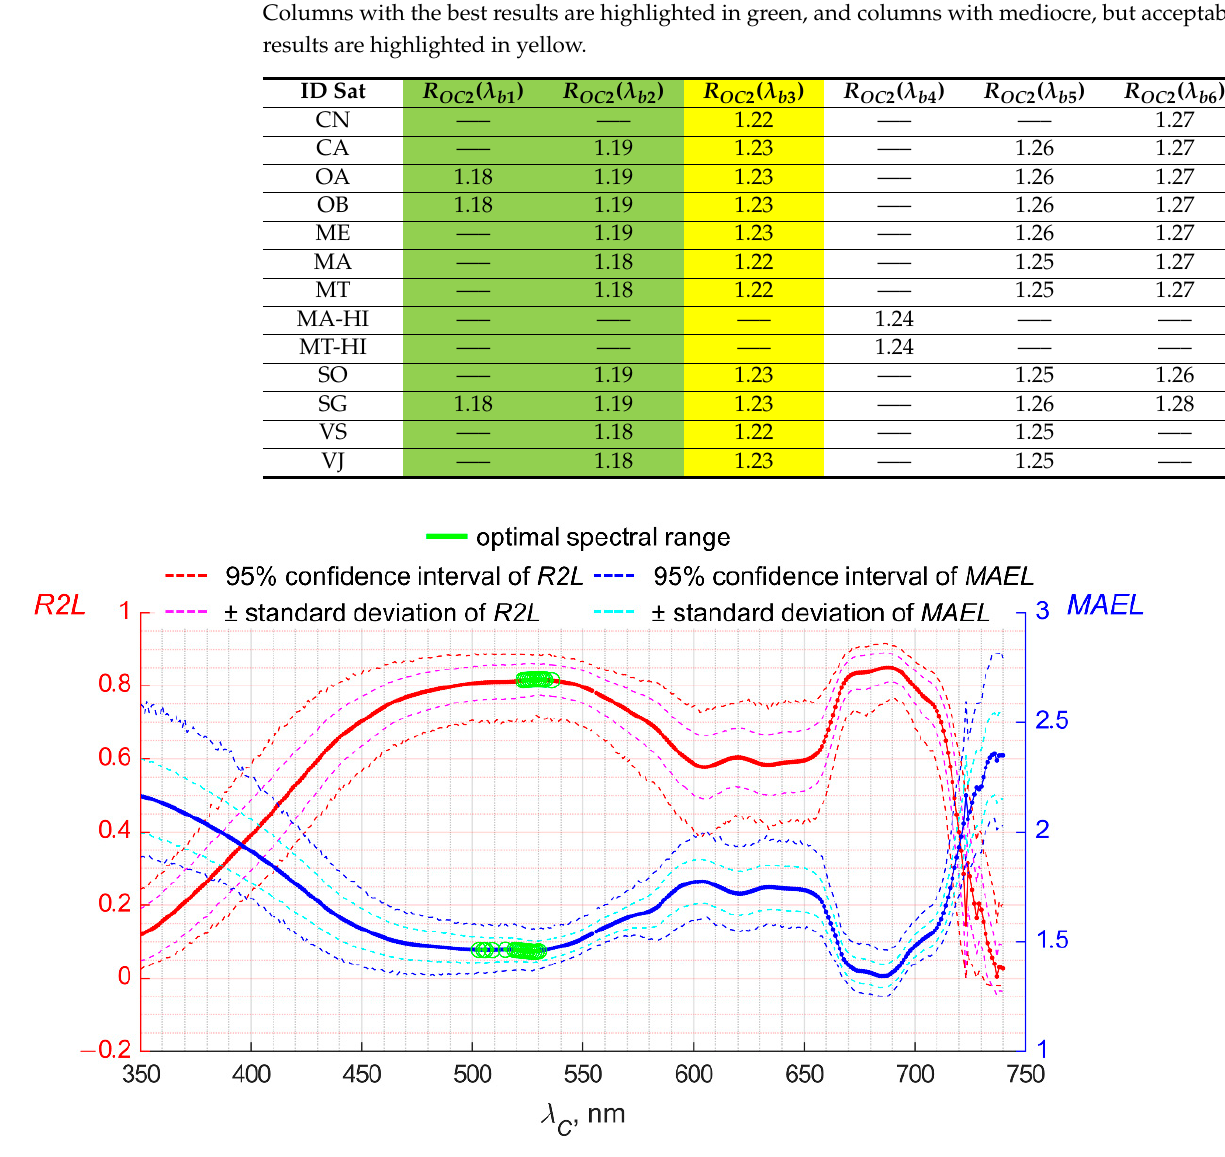
Figure 8. Spectral distribution of R2L and MAEL for the comparison of C ins and C rs calculated using formula (8) from ASD hyperspectral data using R OC 2 ( λ C ) band ratio indices.